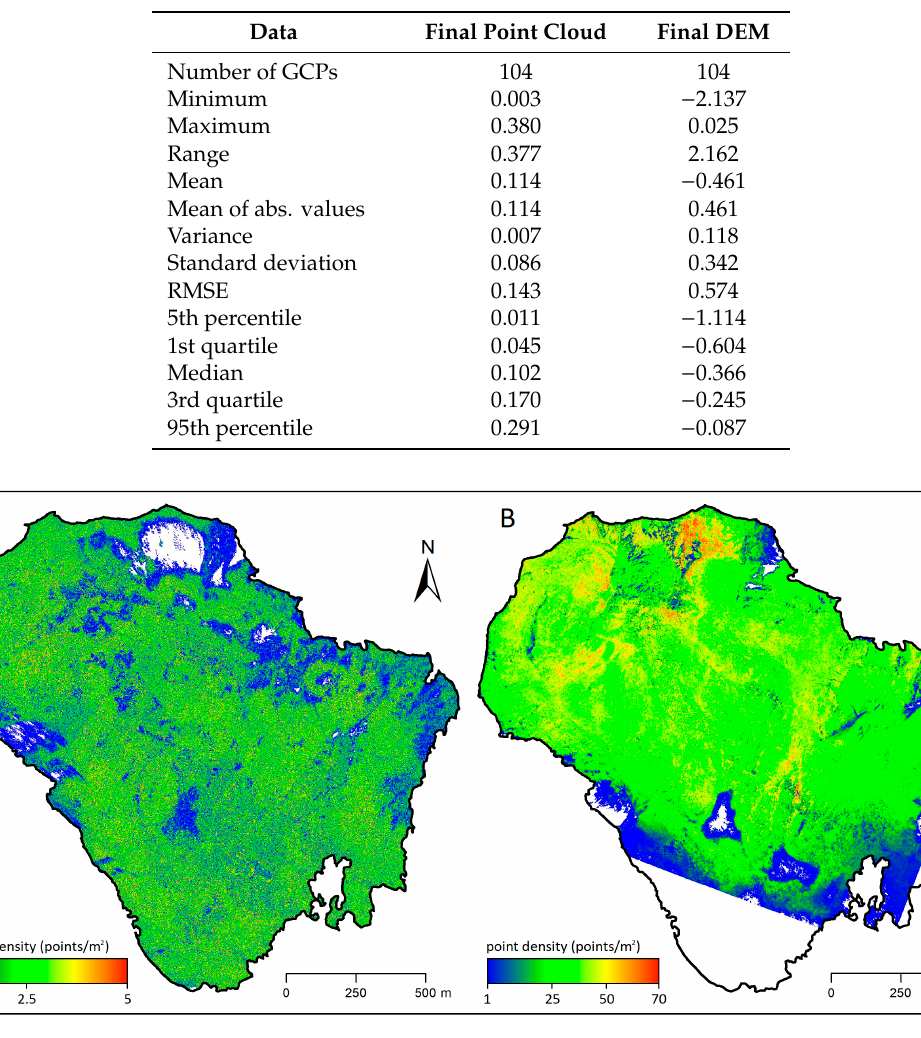
Figure 9. Density of UAV–SfM points acquired in September ( A ) and October ( B ) of